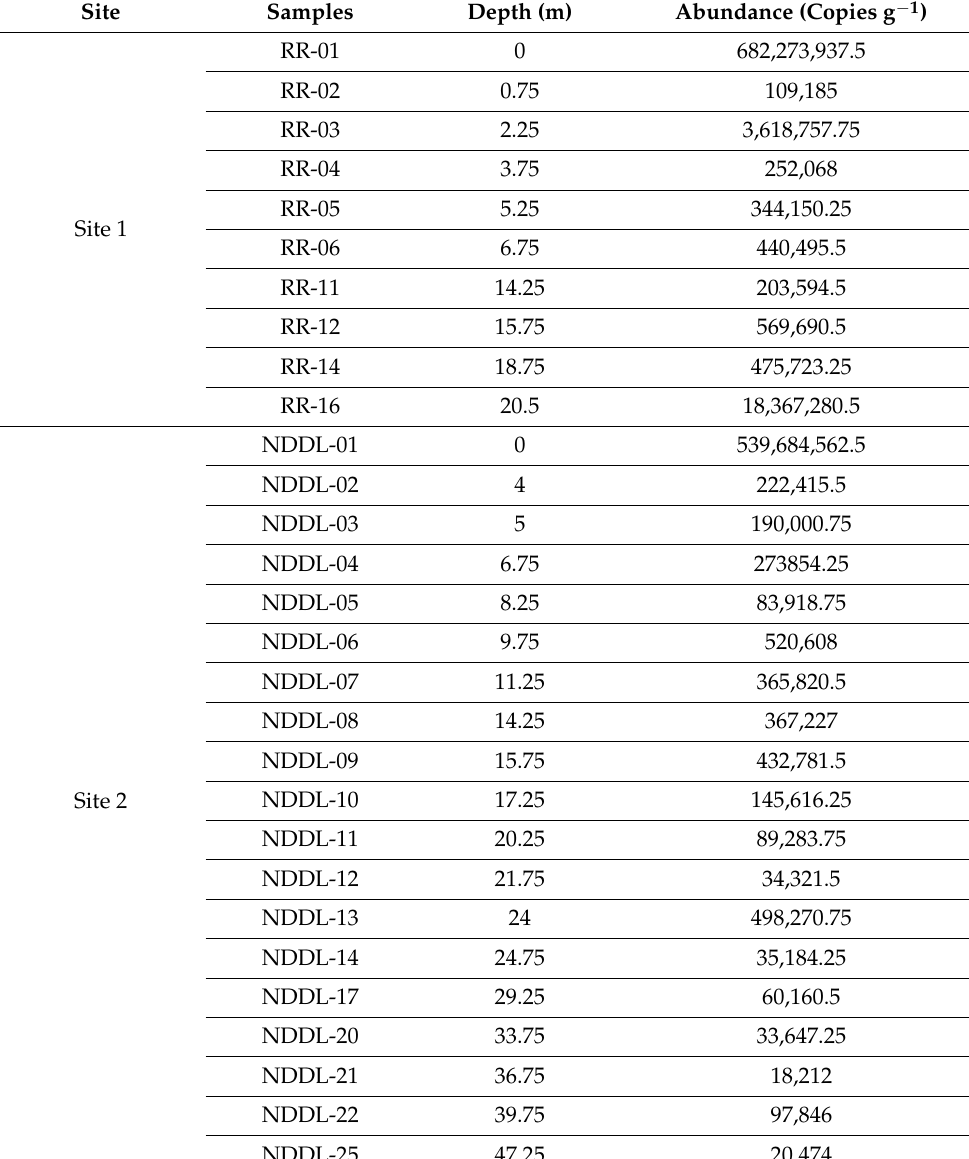
Table 1. Absolute abundances expressed in number of bacterial 16S rRNA gene copies per gram of geological material (copies g − 1 ) detected in each sample. Only values with good quality thresholds are